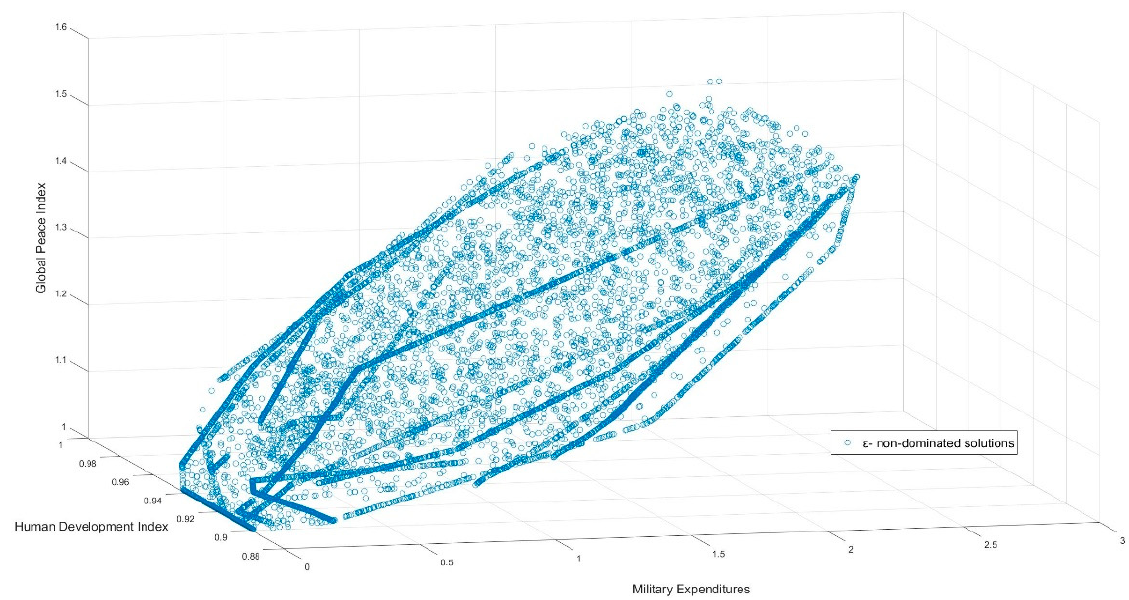
Figure 2. ε -Pareto front.